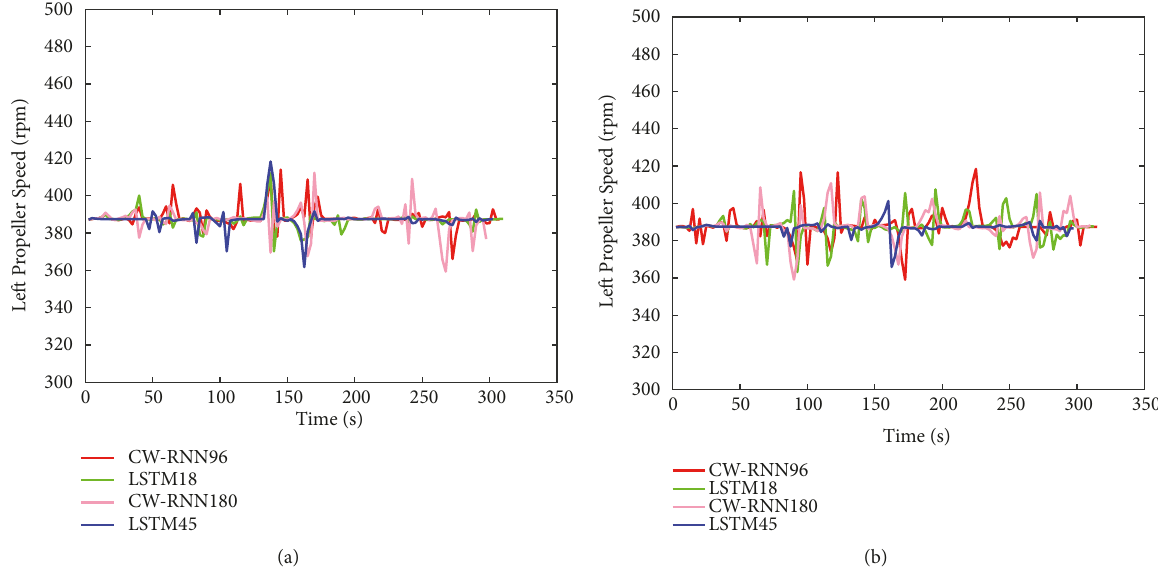
Figure 8: Curves of left propeller speed controlling feedback corresponding with the different obstacle avoidance algorithms in simulation test cases 1(a) and (b).